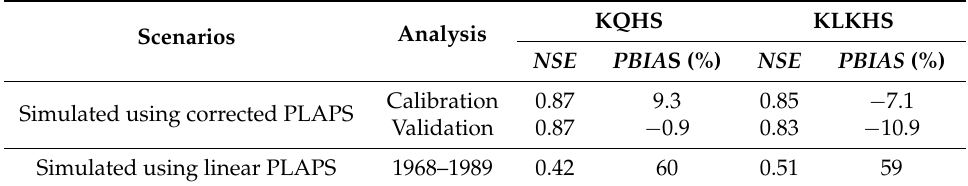
Table 2. NSE and PBIAS results for the simulated monthly streamflow at the Kaqun and Kuluklangan hydrological stations (KQHS and KLKHS) based on corrected and linear PLAPSs from 1968 to 1989 in the Yarkant River basin using the glacier-enhanced SWAT model.